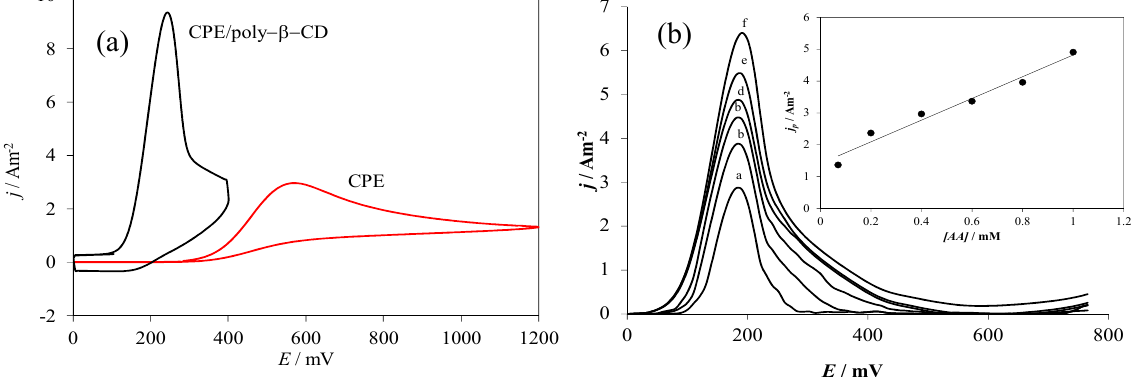
Figure 7. ( a ) Comparison of experimental CV plots recorded in the system electrode/0.1 mM AA, 0.1 M NaCl at pH 3.0, for different electrodes as indicated in the Figure, in both cases at 80 mV s − 1 potential scan rate. ( b ) Family of Differential Pulse Voltammetry plots recorded in the system CPE/poly- β -CD/0.1 M NaCl, at pH 3.0 and different AA concentration: (a) 0.07, (b) 0.1. (c) 0.3, (d) 0.6, (e) 0.8 and (f) 1 mM, at a scan rate of 20 mVs − 1 , the inset show the calibration plot for AA